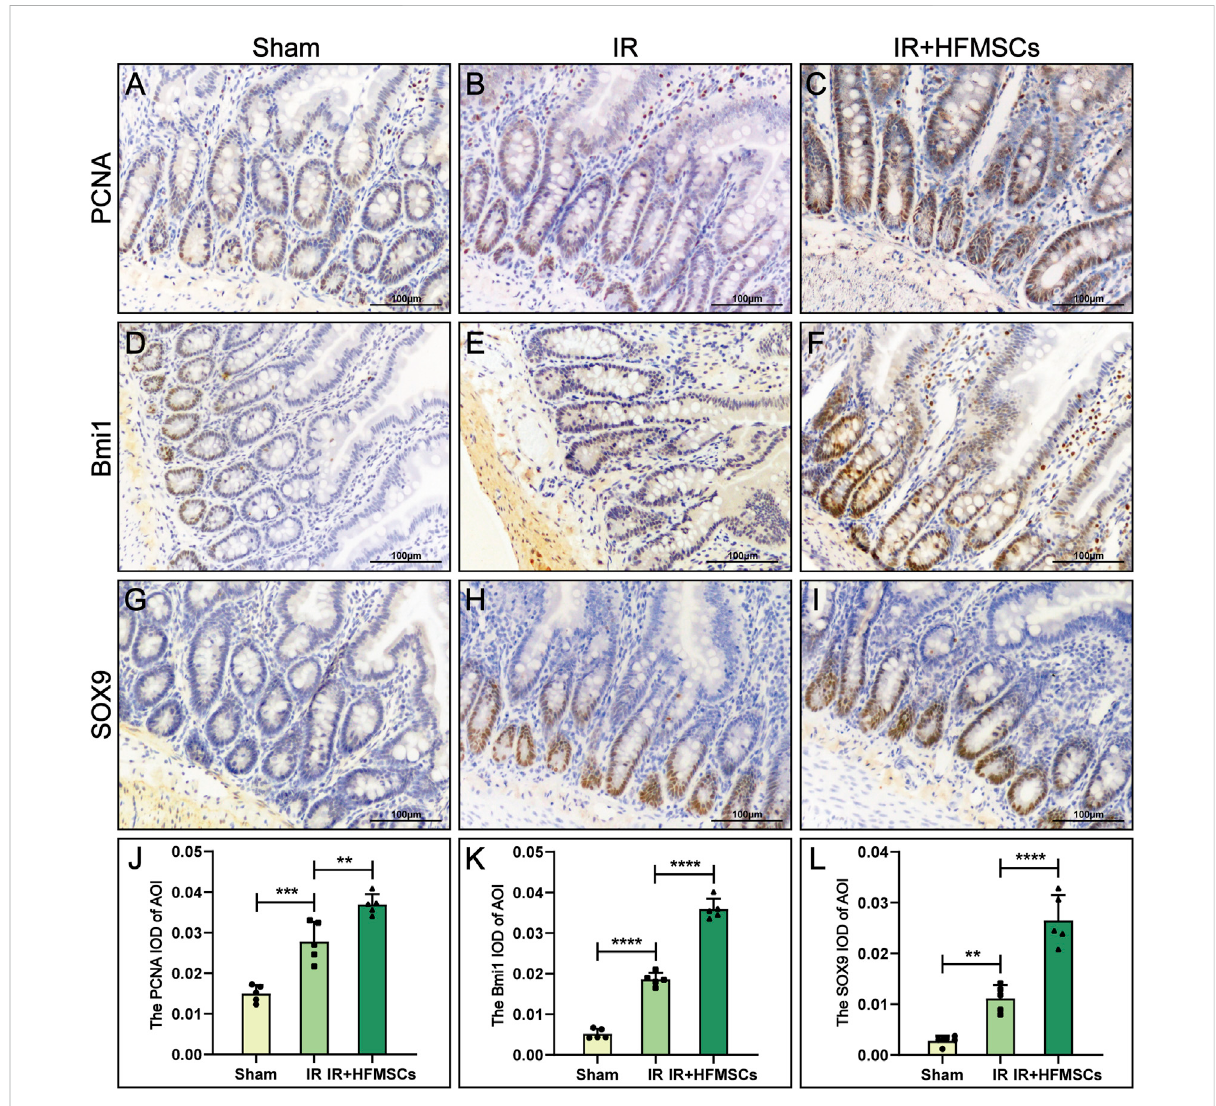
FIGURE 5 HFMSCspromotedtheexpressionofPCNA, Bmi1andSOX9inthesmallintestine. (A – I) ExpressionofPCNA (A – C) ,Bmi1 (D – F) andSOX9 (H – J) intheshamgroup( n =5),IRgroup( n =5)andIR+HFMSCsgroup( n =5). (J – L) StatisticalcomparisonofMODsoftheAOIsofPCNA (J) ,Bmi1 (K) and SOX9 (L) in the sham group, IR group and IR + HFMSCs group. The expression levels of PCNA, SOX9 and Bmi1 in the IR + HFMSCs group were the highest. Data are presented as the mean ± SD (* p < 0.05, ** p < 0.01, *** p < 0.001, **** p <